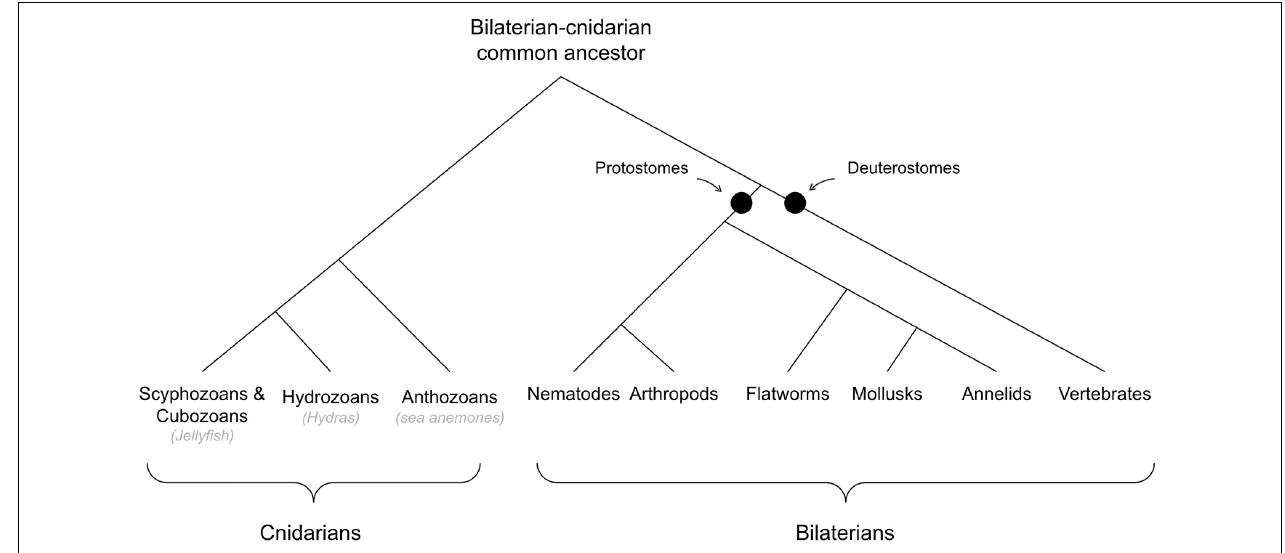
FIGURE 2 | Cladogram of bilaterians and